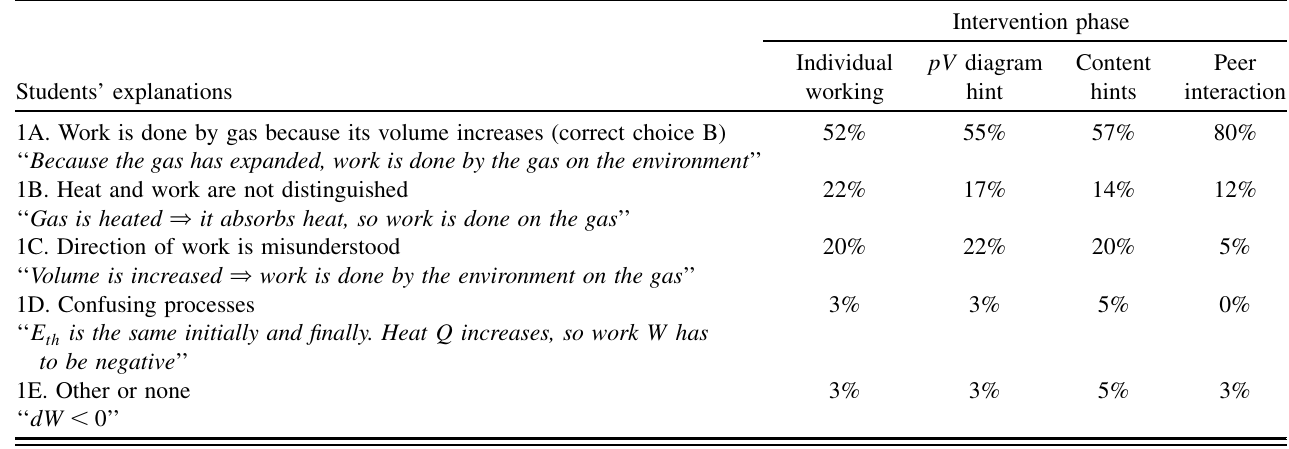
TABLE VII. Students’ categorized explanations regarding the work in an isobaric expansion process. N ¼ 65 . An example from each category is presented after the category symbol in